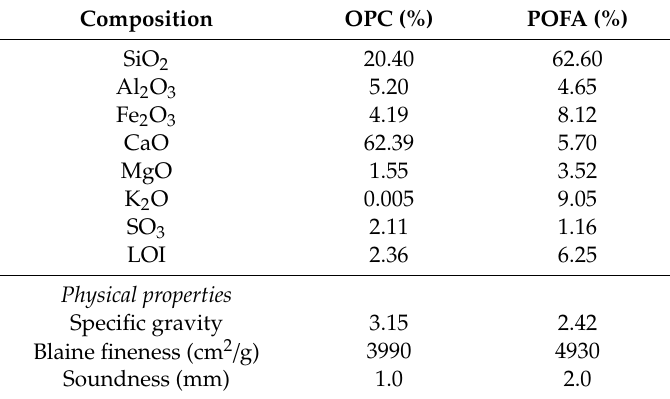
Table 1. Characteristics of used palm oil fuel ash (POFA) and